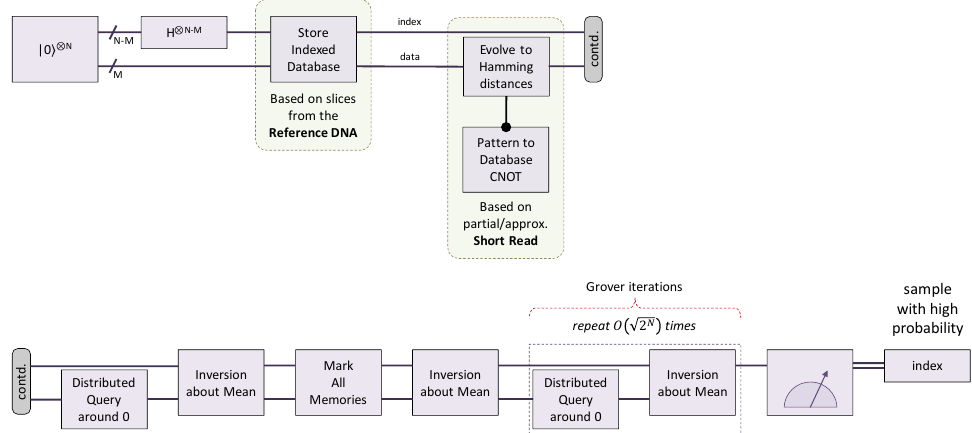
Figure 6. Quantum circuit blocks of the proposed QiBAM